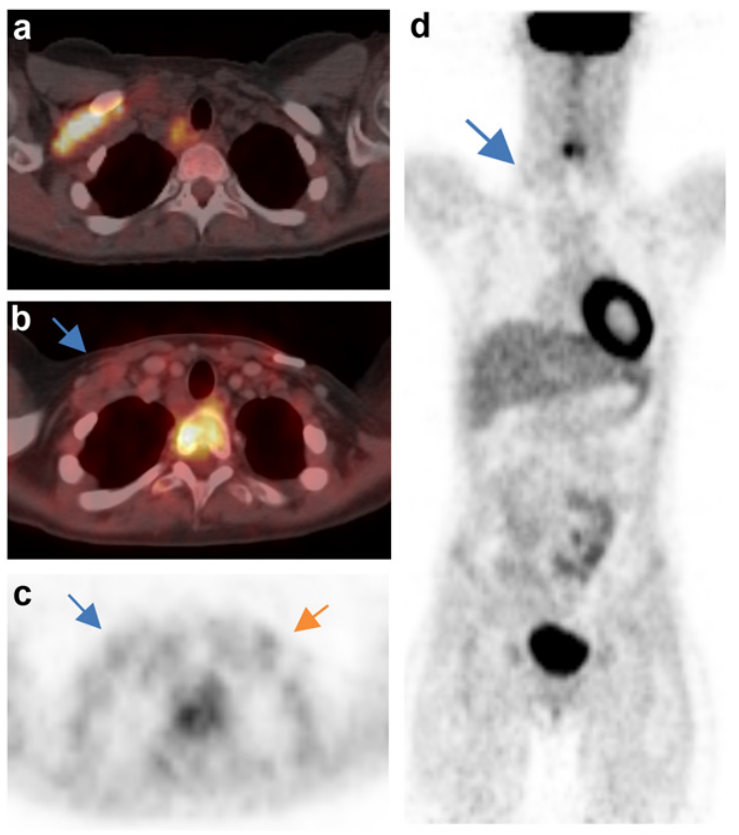
Fig 1. Discrepant D scoring of the right supraclavicular region. Case 63. a) Tumour involvement before treatment. b) Residual mass in this region after two cycles of OEPA. c) and d) slightly enhanced FDG uptake above background in this area. Interpretation might be complicated by a slightly enhanced FDG uptake symmetrically in the left supraclavicular area which, however, is in the surrounding of a catheter and by the inhomogeneous uptake in the mediastinum. Deauville score of the readers R1-5, respectively: 1-1-3-1-2. Courtesy Dept. Nuclear Medicine, Karolinska University Hospital, Stockholm,